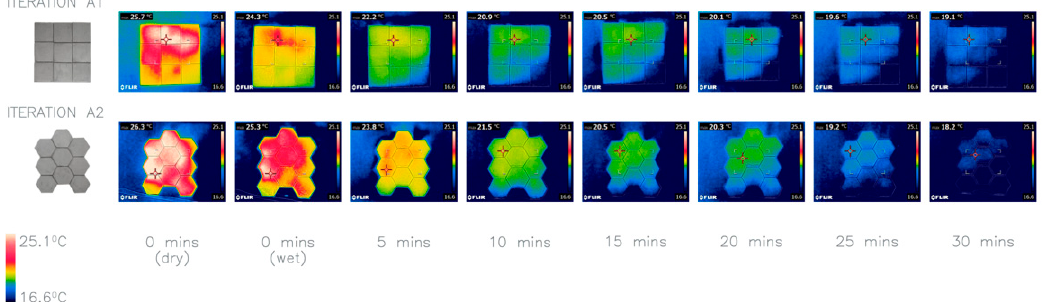
Figure 5. Thermal images of investigation 2: comparison of two different shapes with smooth surfaces and same SA:V ratio (2.39). Average temperature drops by 6.6 °C for the square and 8.1 °C for the hexagon.